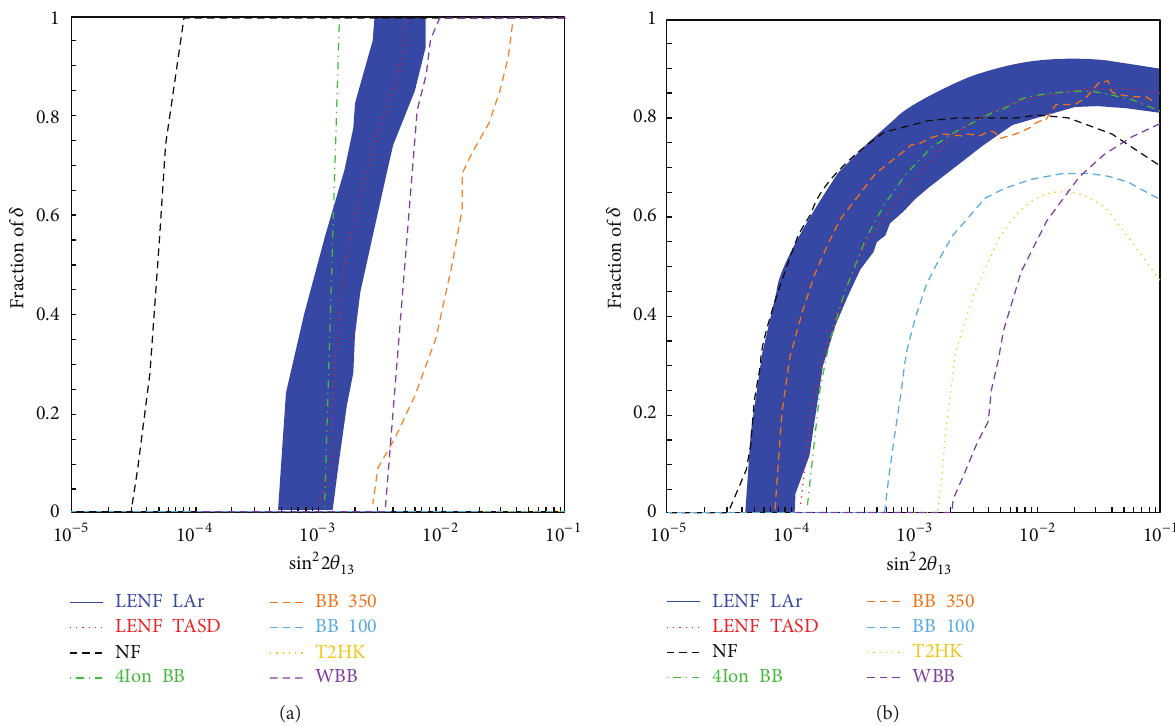
Figure 16: (a) 3𝜎 sensitivity to the mass hierarchy, in terms of the fraction of 𝛿 values for which 𝛿 = 0 , 𝜋 can be excluded, as a function of sin 2 2𝜃 13 with a LENF with 20kton TASD, LENF with 100kton LAr detector (the band corresponds to the varying detector performance), high energy neutrino factory, a wide band beam, 3 betabeam configurations and for T2HK. Figure is taken from [144] where further details of the simulations are reported. (b) Same as the left but for CP